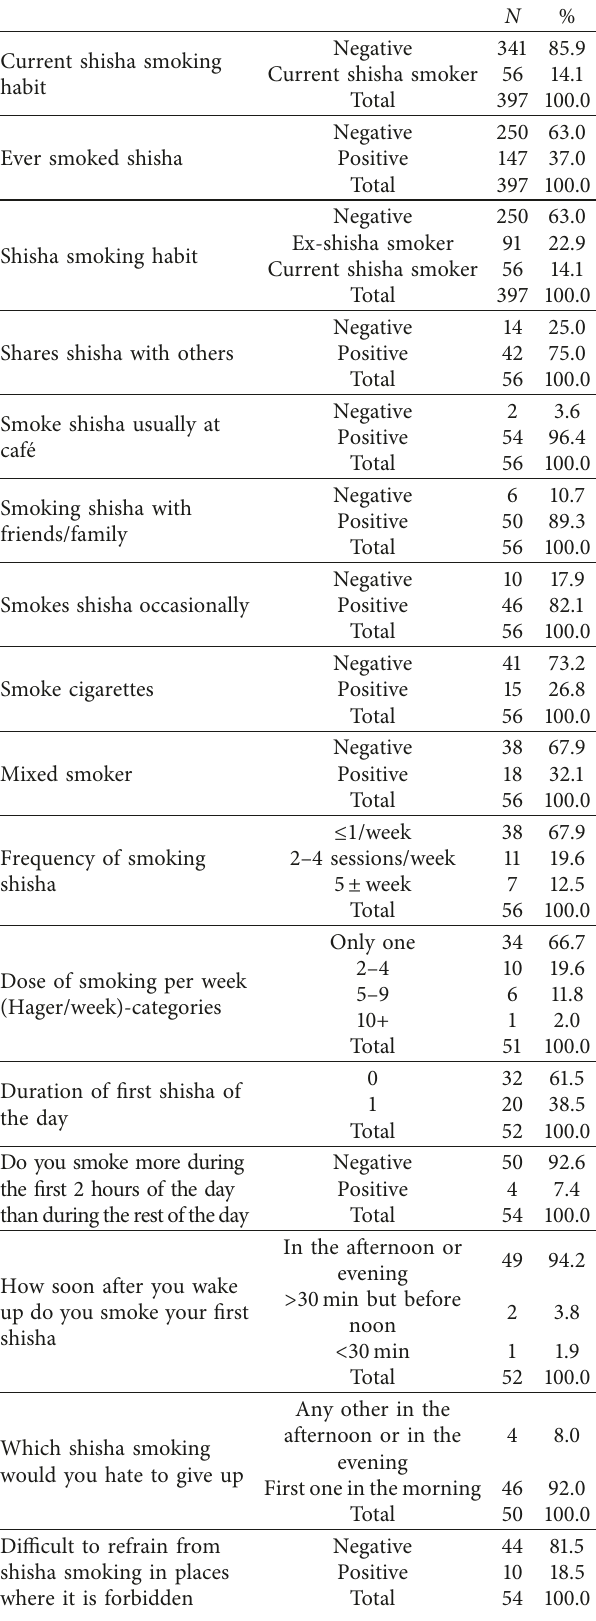
Table 12: Personal smoking